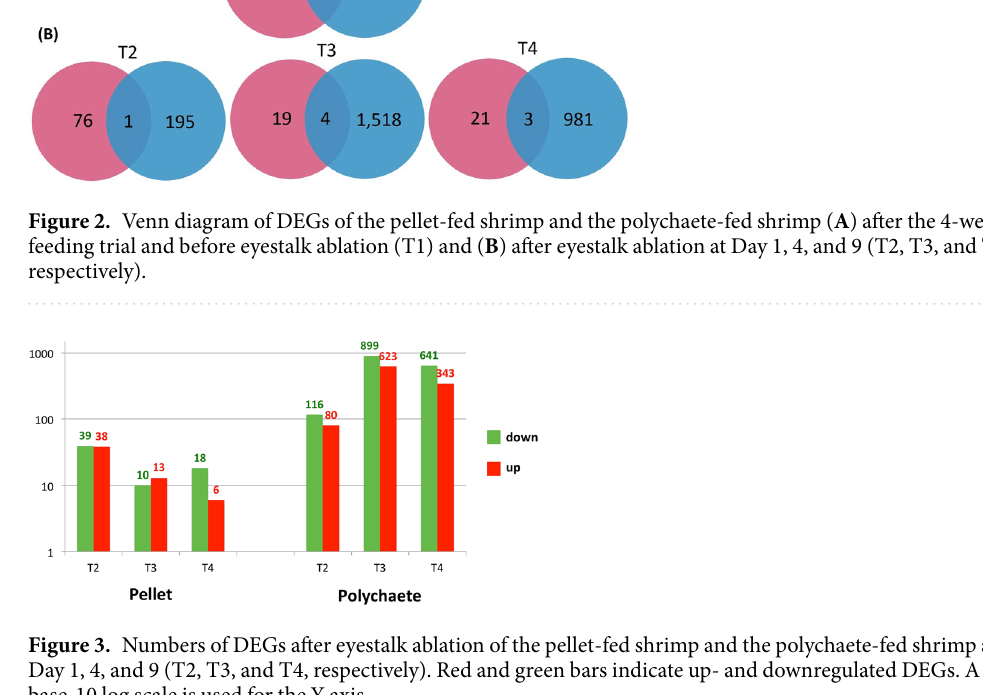
Fig. S1, Table S4). Among genes annotated to various molecular functions, the largest category was ATP binding (597), followed by metal ion binding (286) and nucleic acid binding (271), another ten subcategories with 100 or more terms (Supplementary